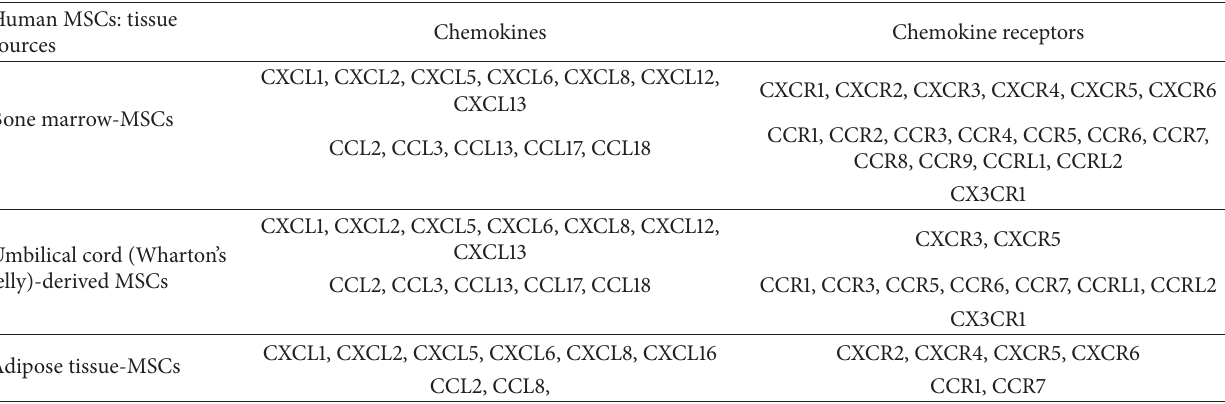
Table 2: Comparative data on chemokines and chemokine receptors expressed in different human MSC populations [50, 53–60]. Human MSCs: tissue